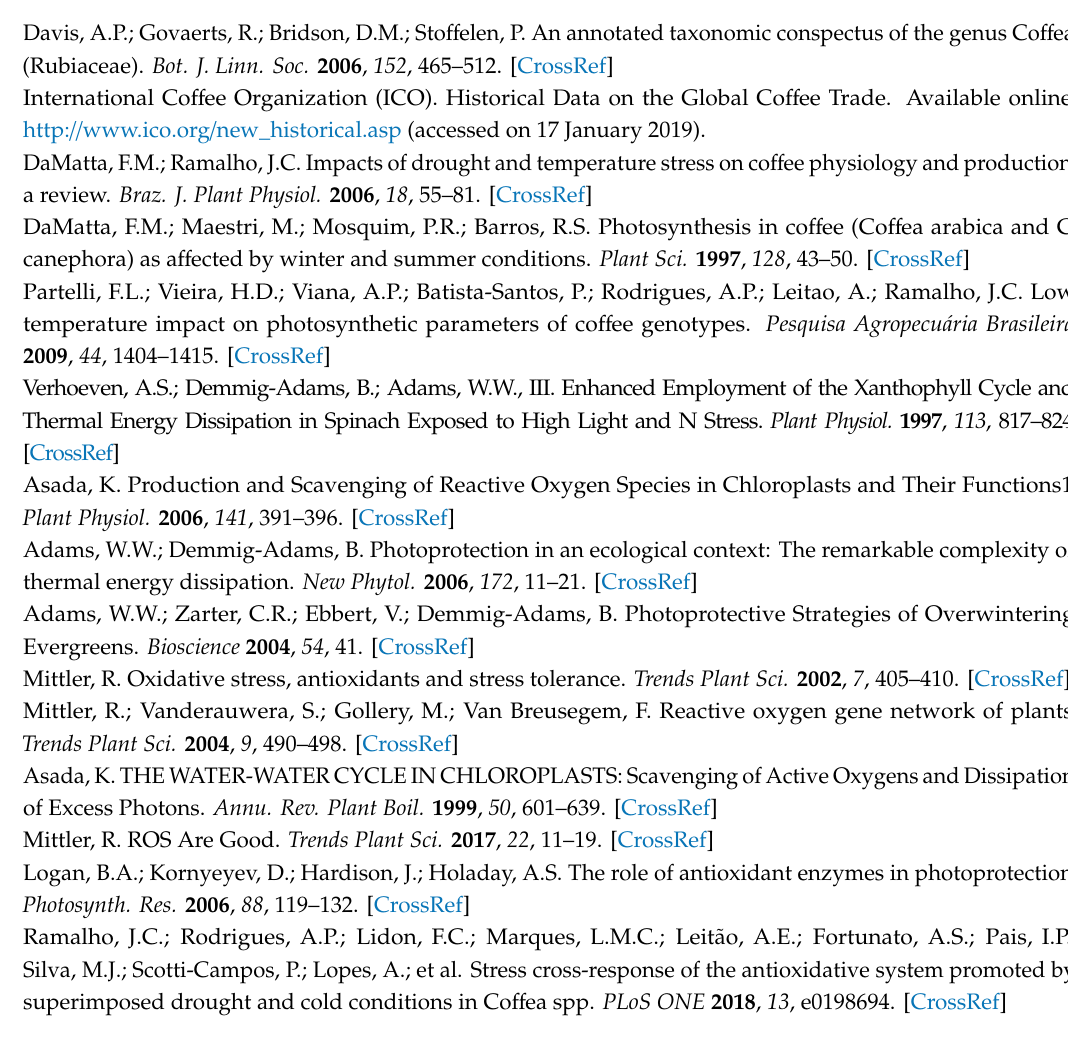
Table S1: structural formulae of the compounds depicting the hydroxyl components and glycosylic linkages that scavenge ROS; Table S2: variation in the composition of the flow liquid during the HPLC linear gradient mode; Figure S1: HPLC chromatogram of the extracted co ff ee leaf sample, displaying peaks for trigonelline, 5-CQA, ca ff eine and mangiferin at 4.58, 18.82, 20.23 and 22.31 minutes,